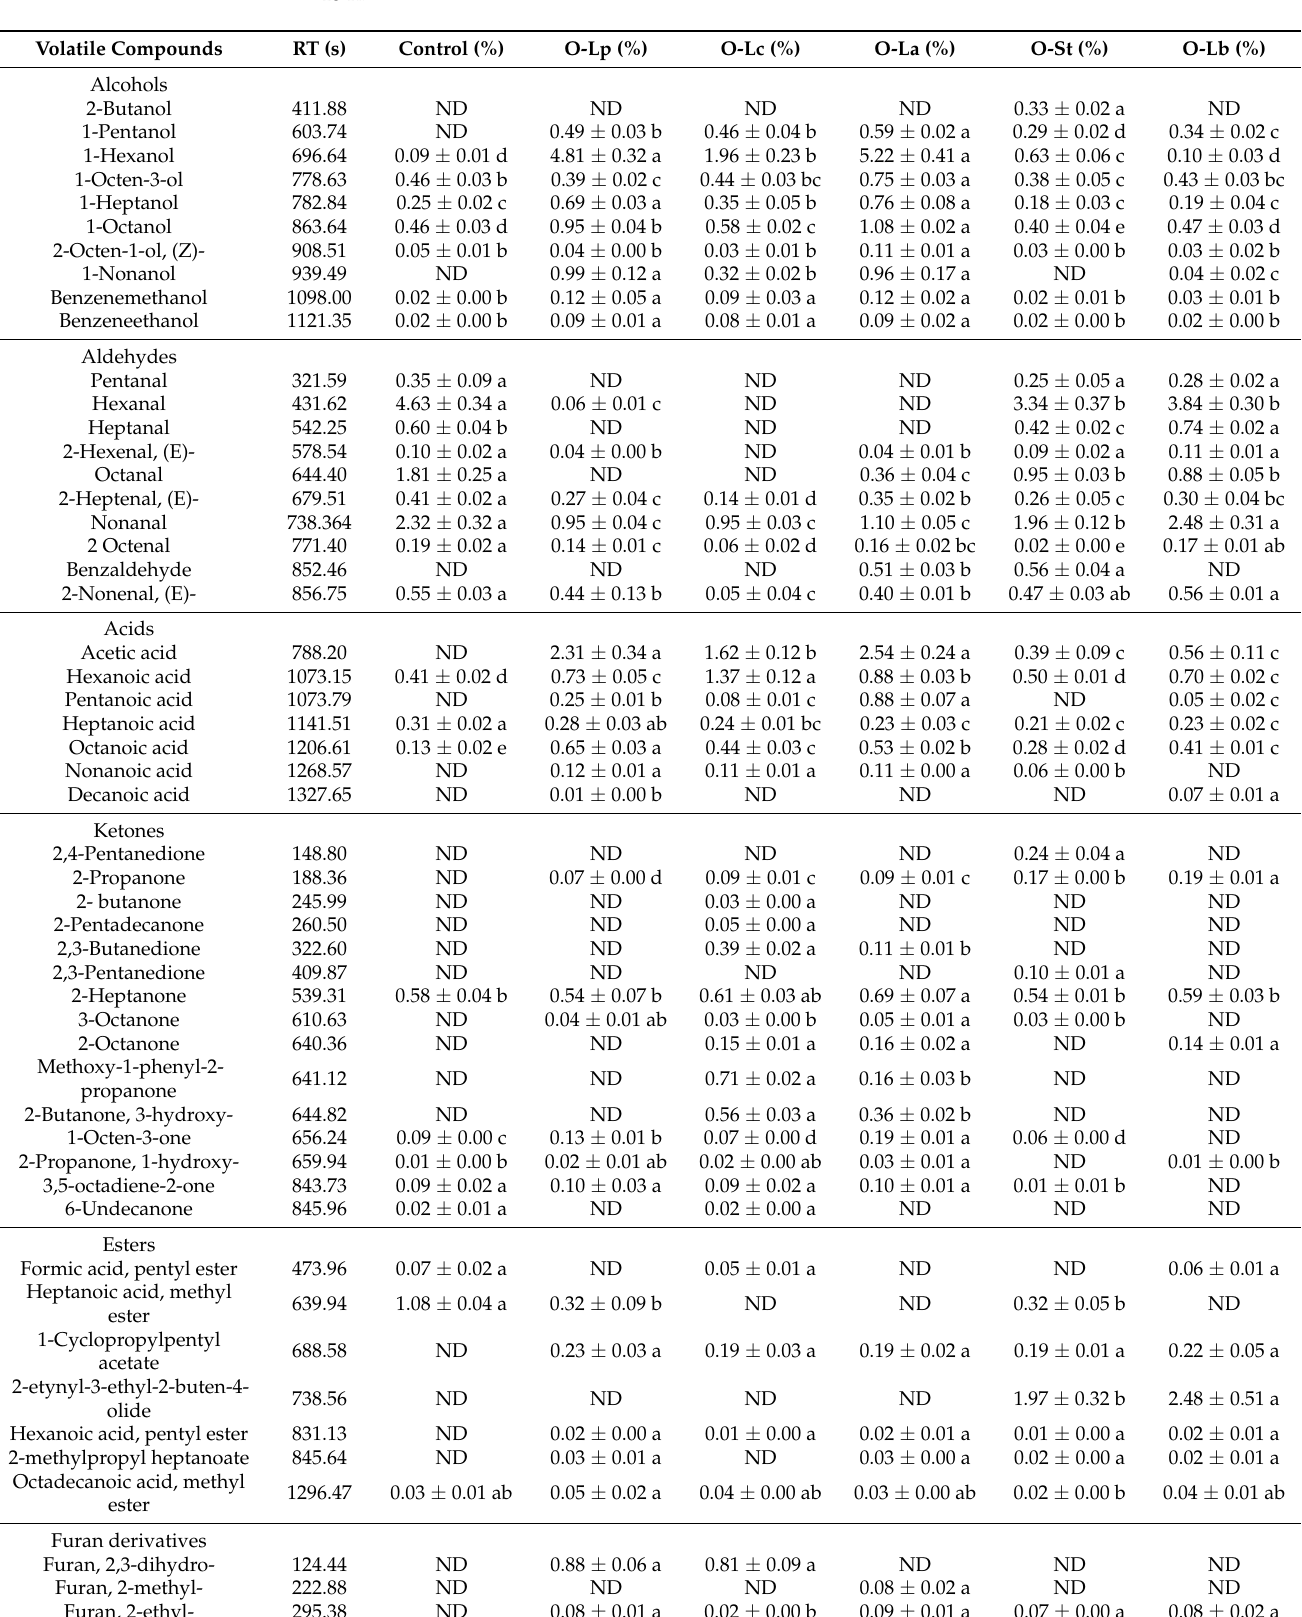
Table 2. Changes of volatile compounds in oat samples fermented by different lactic acid bacteria for 48